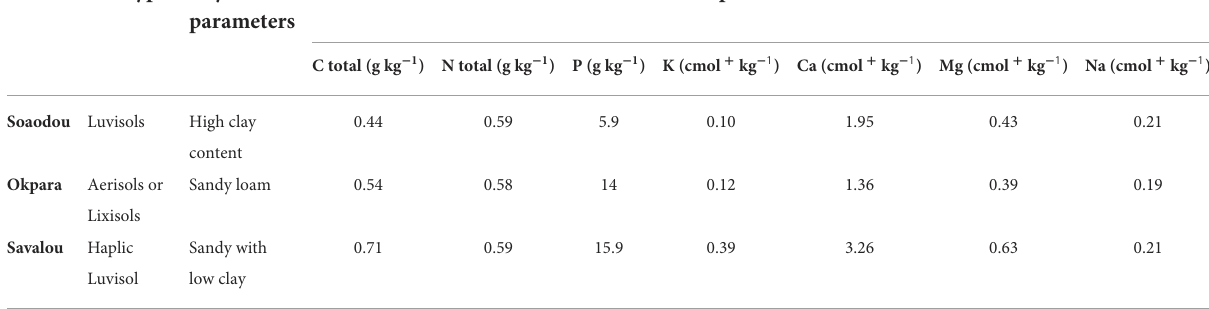
TABLE 1 Physico-chemical characteristics of the soil at experimental sites.